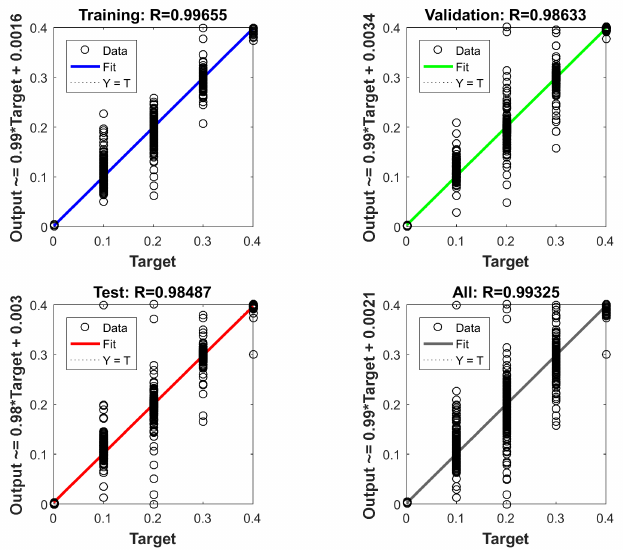
Figure 23. Fitting degree of expected results and test results of fluid velocity.